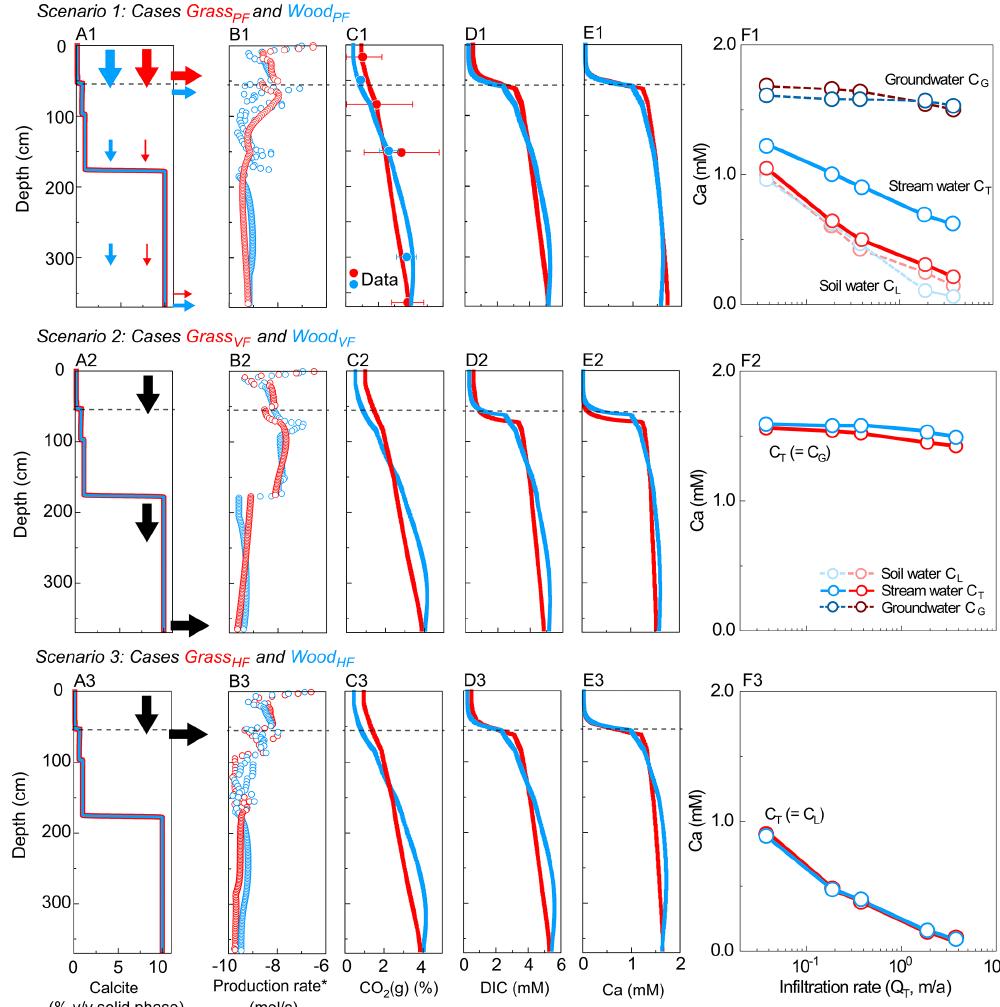
Figure 3. Simulated depth profiles of (A) calcite (vol%) and (B) soil CO 2 production rate; (C) CO 2 (g) (%), (D) DIC, and (E) Ca at 0.37m/a; and (F) effluent Ca concentrations at different infiltration rates. From top to bottom rows are Scenario 1 (Grass PF and Wood PF , with flow partitioning, first row), Scenario 2 (Grass VF and Wood VF , with 100% vertical flow, second row), and Scenario 3 (Grass HF and Wood HF , with 100% lateral flow, last row). Red and blue colors present grassland and woodland, respectively. Lines and empty circles represent modeling outputs, while filled circles with error bar in C are the annual-average CO 2 (g) data (in Table 2). Arrows in A indicate flow conditions. In F, soil water and groundwater refer to concentrations at the lateral (50cm) and vertical (366cm) outlets, respectively. Higher fractions of vertical flow in Wood PF led to higher stream Ca concentration compared to Grass PF . In Scenario 2 and 3 without flow partitioning, stream Ca concentrations were similar. The concentrations of DIC versus discharge are very similar to the Ca concentrations in